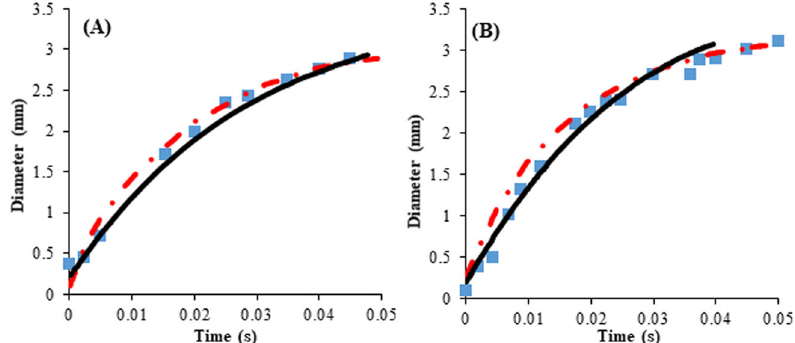
Fig. 1 Veri fi cation of the developed model with experimental and numerical data. Validation of simulation results of the bubble growth process with published empirical results 22 and numerical data: ( A ) superheat with temperature and contact angle of 7°C and 50° ( B ) with temperature and contact angle 8.5°C and 50°. Experimental 22 ( ), Computational 22 ( ), and present work (NOE = 9632) ( ).